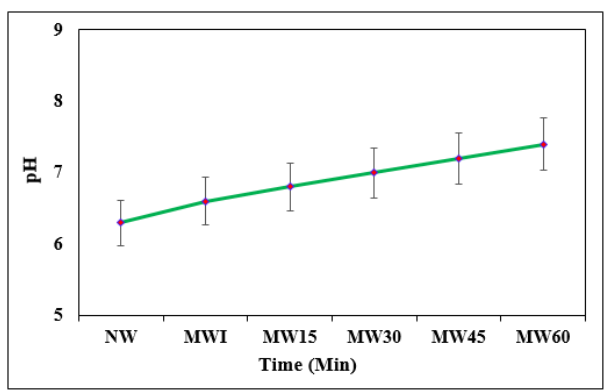
Figure 4. pH variation of NW and MW with exposure